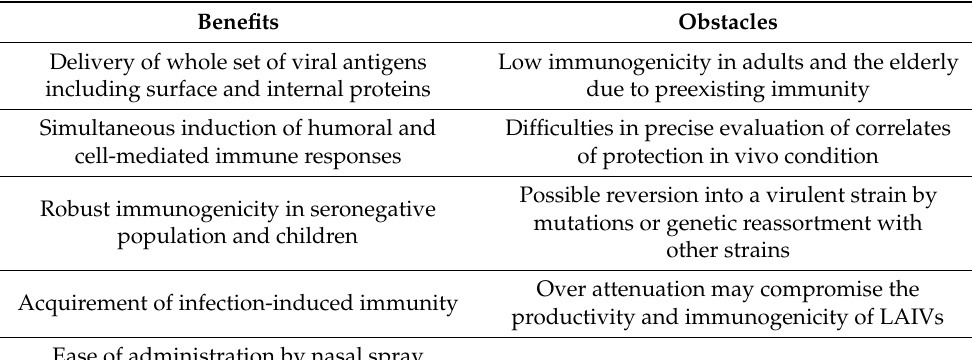
Table 3. Benefits and obstacles in using LAIVs as UIVs. Benefits Obstacles Delivery of whole set of viral antigens Low immunogenicity in adults and the elderly including surface and internal proteins due to preexisting immunity Simultaneous induction of humoral and Difficulties in precise evaluation of correlates cell-mediated immune responses of protection in vivo condition Possible reversion into a virulent strain by Robust immunogenicity in seronegative mutations or genetic reassortment with population and children other strains Over attenuation may compromise the Acquirement of infection-induced immunity productivity and immunogenicity of LAIVs Ease of administration by nasal